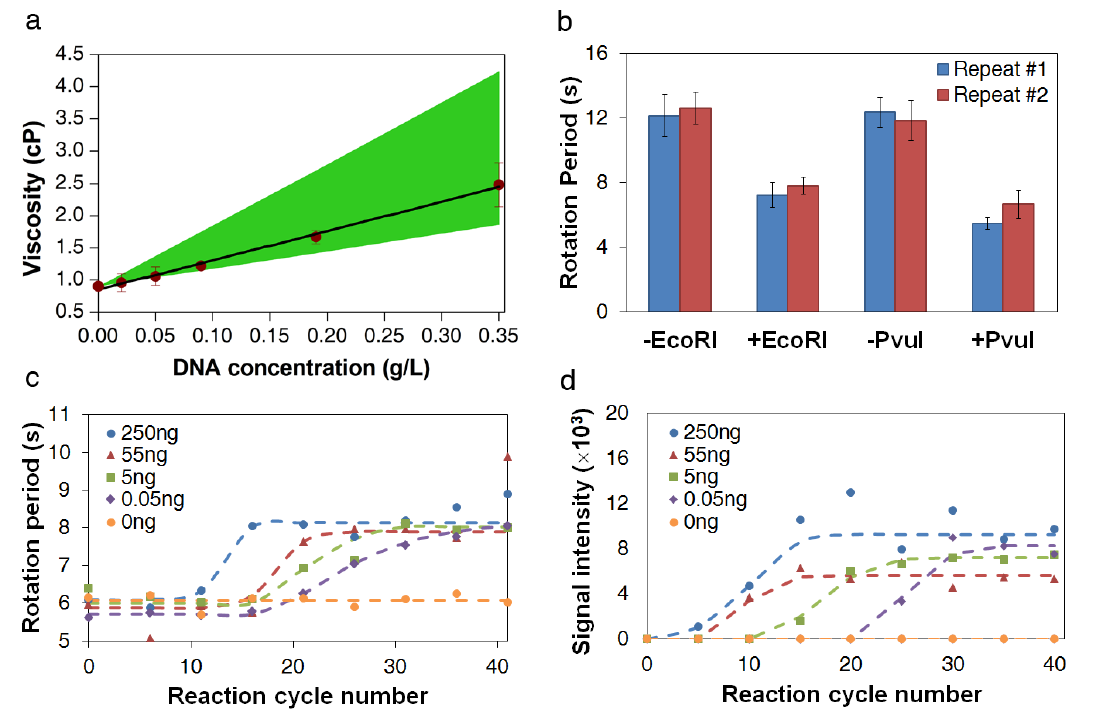
Figure 3. DNA measurement using AMBR microviscometer. ( a ) Viscosities of lambda DNA Eco RI digest solutions at different concentrations, as measured by AMBR microviscometer. The green area indicates the expected range of the viscosity calculated theoretically, assuming that only the longest (top range) or only the shortest (bottom range) DNA fragment size is present. Error bars represent standard deviation among 10 beads in one measurement. ( b ) Measurement of bead rotation period of pre- and post-digestion samples of lambda DNA by AMBR microviscometer. The field driving frequency is 150 Hz. The error bars show the standard deviation among 10 beads in each measurement. ( c ) Measurement of viscosity by bead rotation period in PCR reactions sampled every 5 cycles, starting from the 6th cycle. PCR reactions with initial DNA amounts of 0 ng, 0.05 ng, 5 ng, 55 ng, and 250 ng are shown. The reaction volumes are 50 µL each. The represents the mean value, observing ten beads. ( d ) Fluorescent signal intensities of the PCR product (4500 bp band) observed on a electrophoresis gel for the same samples measured in ( c